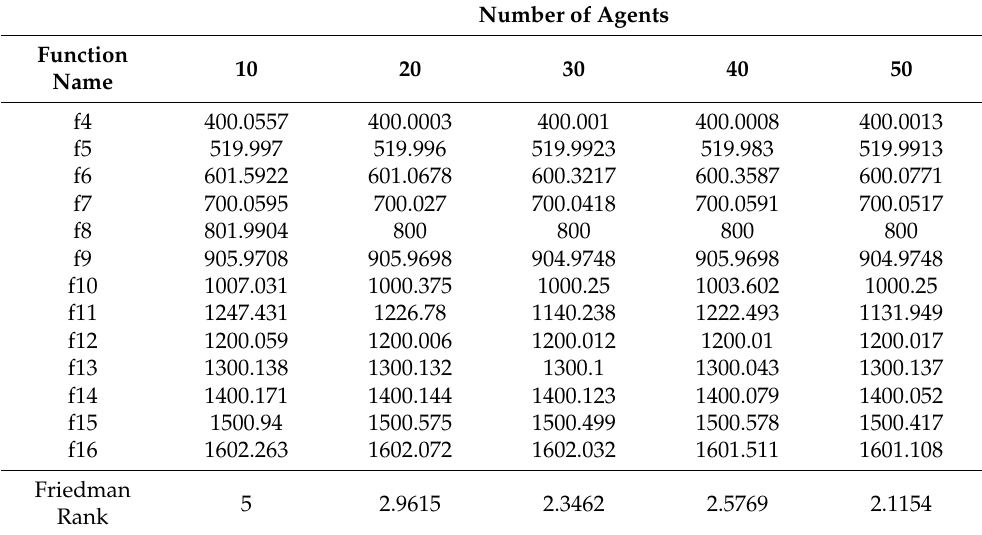
Table 2. Effect of Number of Agents.